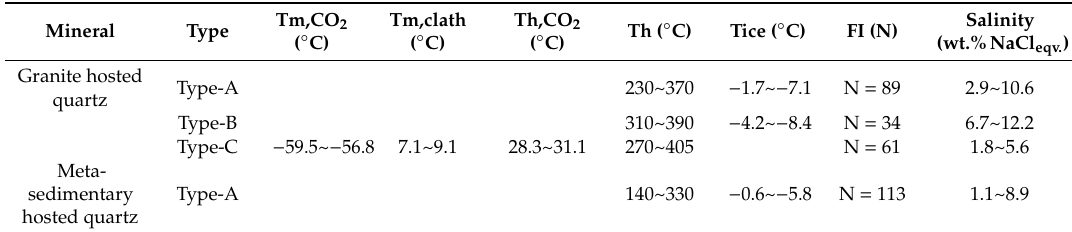
Table 2. Summary of fluid inclusion types and microthermometric data of the Tagu Sn–W deposit, Southern Myanmar.